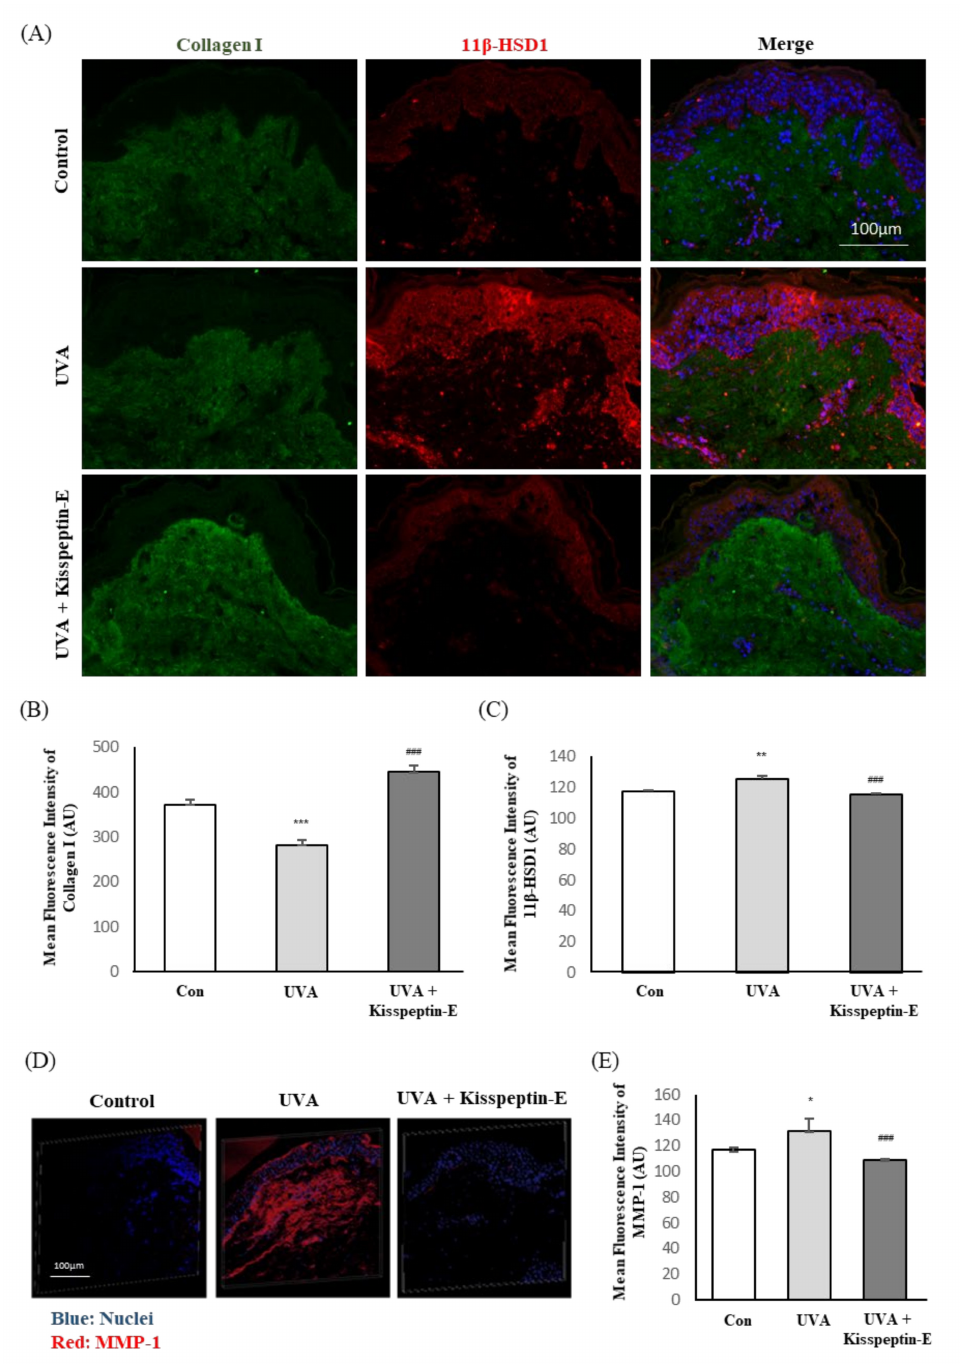
Figure 5. Kisspeptin-E regulated the 11 β -HSD1, type I collagen, and MMP-1 protein expressions in the UVA irradiated human skin explant model. Human skin explants were topically treated with Kisspeptin-E before, during, and after UVA irradiation. The proteins of ( A , B ) type collagen I and ( A , C ) 11 β -HSD1 were labeled by immunofluorescence and observed by fluorescence microscopy (DM5000B–Leica-Microsystems). Ten areas were observed by samples. ( C , E ) The measured fluorescence was quantified by image analysis (Image J). ( D ) The MMP-1 enzyme was labeled by immunofluorescence and observed by confocal microscopy (Zeiss LSM510 NLO). ( D , E ) The 3D representation and the mean fluorescence intensity of staining are shown. *** p < 0.001, ** p < 0.01 indicates a significant di ff erence from the control. ### p < 0.001 indicates a significant di ff erence from the UVA-irradiated